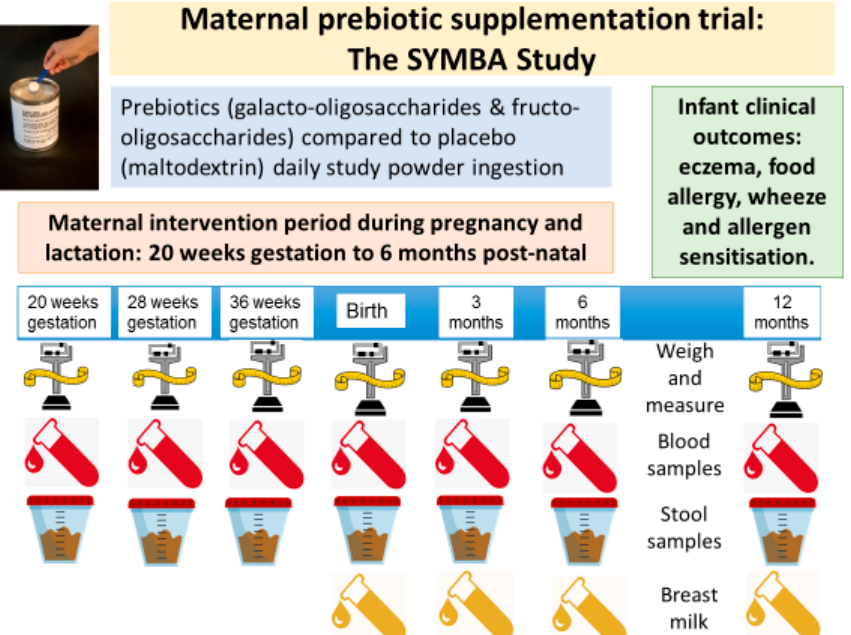
Figure 1. Figure 1 summarizes the participants (maternal and child) schedule of appointments and biological sample collections. The maternal intervention period is from 18–20 weeks’ gestation until 6 months’ post-partum, when the participating women are asked to consume their allocated study powder daily. Child assessments occur at 3, 6 and 12 months of